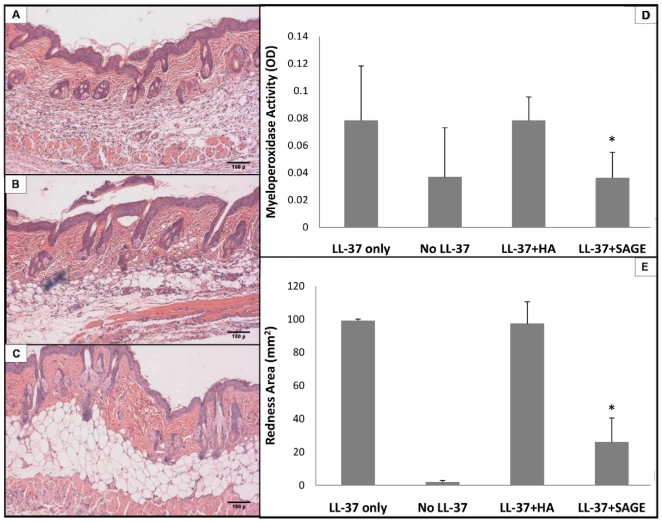
HA emollient does not reduce LL-37-induced inflammation.Experiments were performed as in Figure 7, but with immediate (t = 0) application of 1% w/w HA-containing emollient (53 kDa HA) or 1% w/w GM-1111 emollient. *P<0.05 vs LL-37 alone. A. H&E-stained cross-sectional view of LL-37 injected skin. B. H&E-stained section of LL-37 injected skin treated with topical HA emollient alone. C. H&E-stained section of LL-37 injected skin treated with topical emollient containing 1% SAGE GM-1111. D. MPO activity measurement of LL-37 injection with different treatments. E. Area of erythema from LL-37 injection. Erythema scores after LL-37 injection were: 5.1±0.1 after LL-37 alone; 4.9±0.44 after LL-37+ HA; 2.3±0.7 after LL-37+ SAGE (P<0.05 LL-37 alone vs LL-37+ SAGE). *P<0.05 vs intradermal LL-37 alone; n = 6 per group.